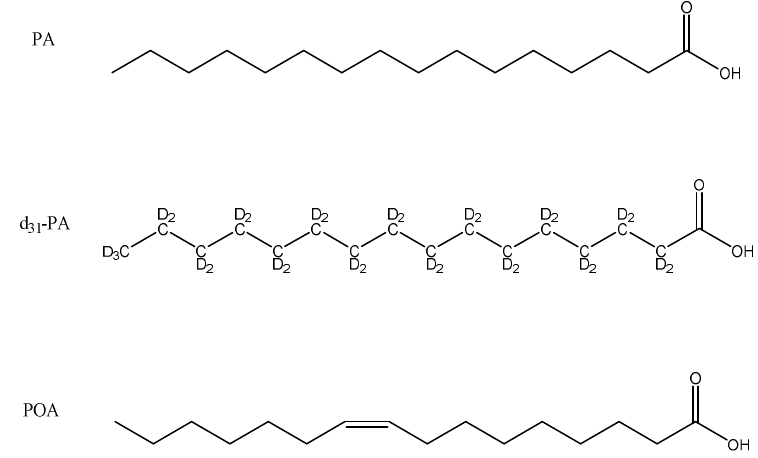
Figure 2. Molecular structures of the fatty acid species employed in the present study.